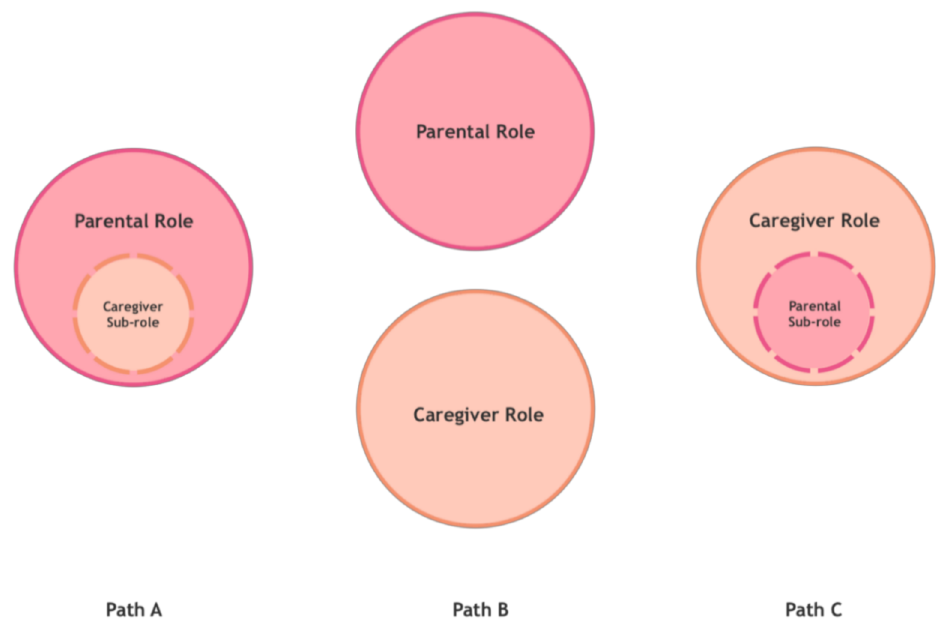
Figure 2. Changes in the parental